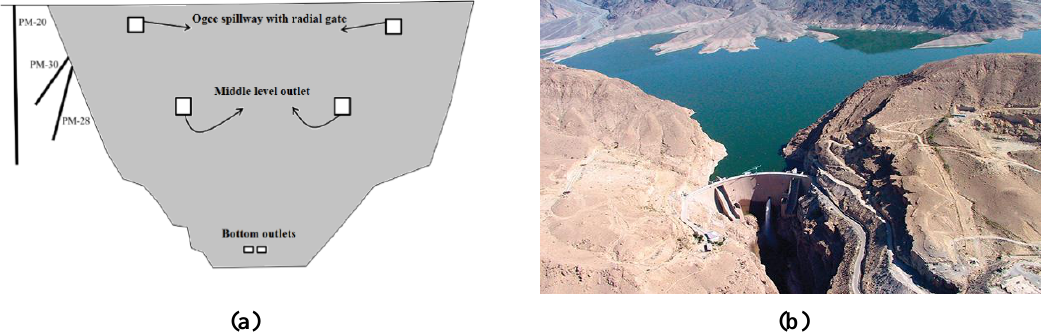
Figure 1. (a) Aerial image of Jiroft double-curvature arch concrete dam in Kerman province, Iran; (b) Schematic image of cross section of dam and location of piezometers used in this study, which are situated at left bank retain wall in the body and rock (rock is the foundation) of the